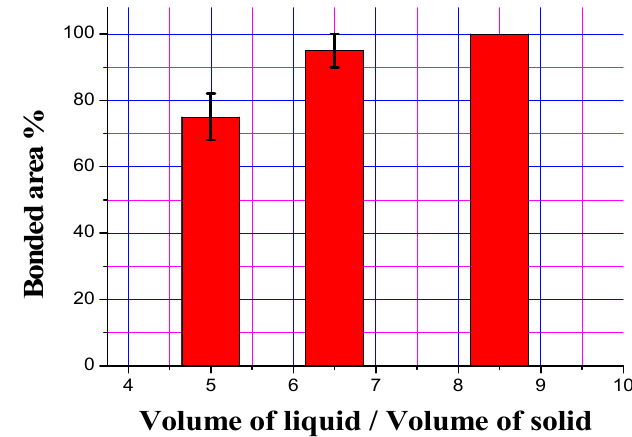
Figure 10. E ff ect of volume ratio of liquid Al alloy to solid steel substrate on bonded interface area of 1:10 Sn: flux tinned steel substrate.